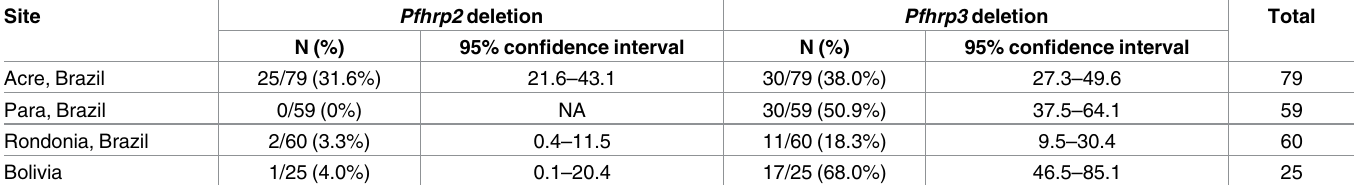
Table 1. Pfhrp2 and pfhrp3 gene deletions among samples collected in Brazil (198 samples) and Bolivia (25 samples).